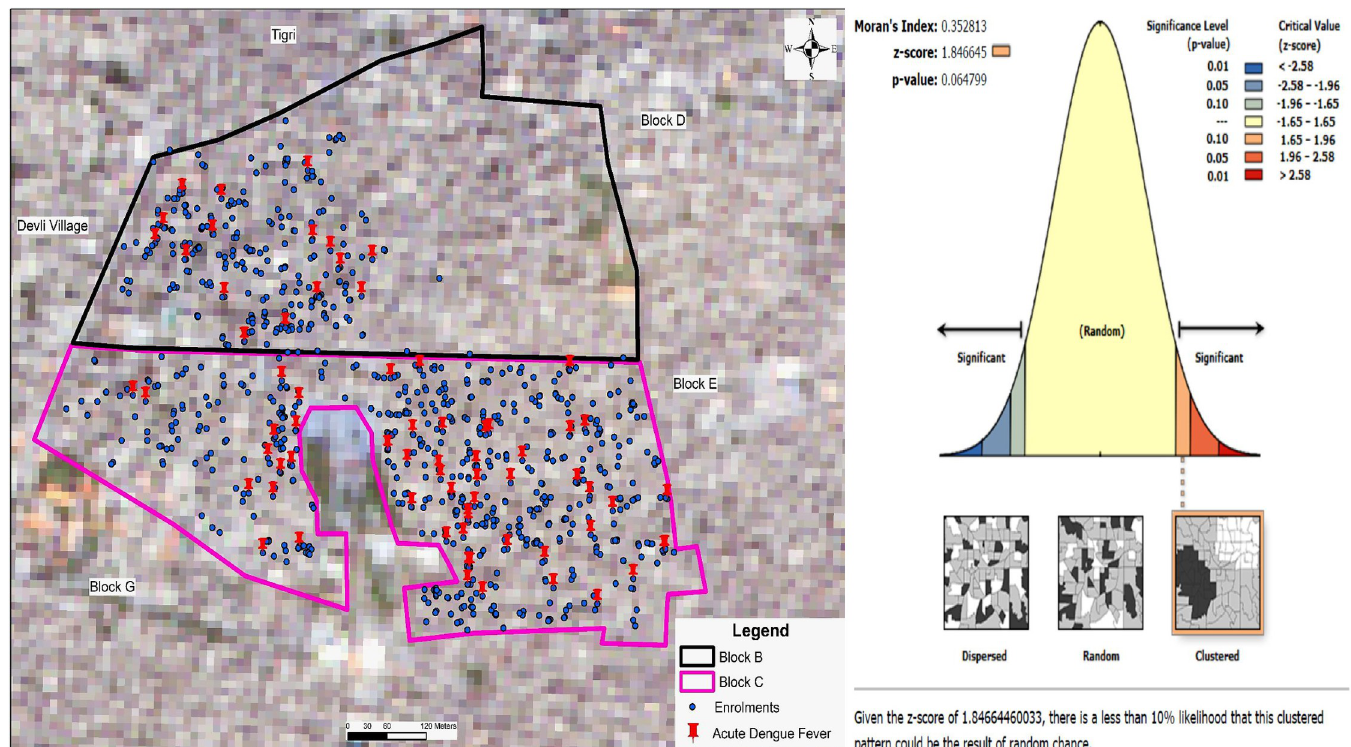
Fig 3. Geographic distribution of acute dengue fever cases in the study area. Figure legend: Moran’s Index = 0.353, Variance = 0.04, z-score = 1.85, p-value = 0.06. Given the z-score of 1.85, there is a less than 10% likelihood that this clustered pattern could be the result of random chance. https://doi.org/10.1371/journal.pntd.0010333.g003 (1.1 to 6.7) per 1000 PY. Incidence of acute dengue fever was observed to be highest among chil-